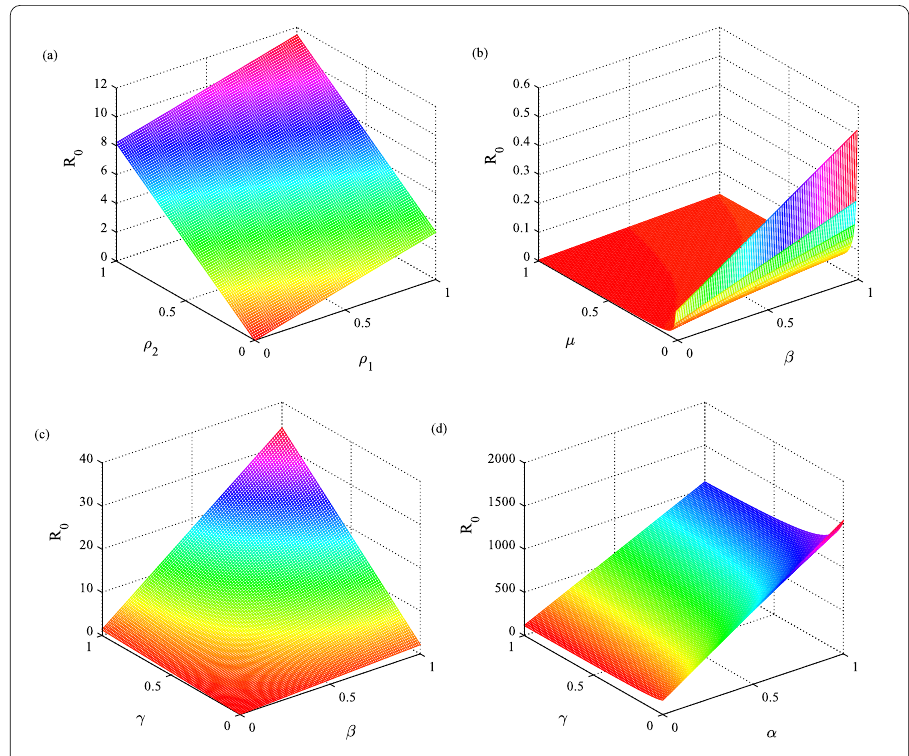
Figure 3 The relationship between the basic reproductive number R 0 and the parameters on scale-free